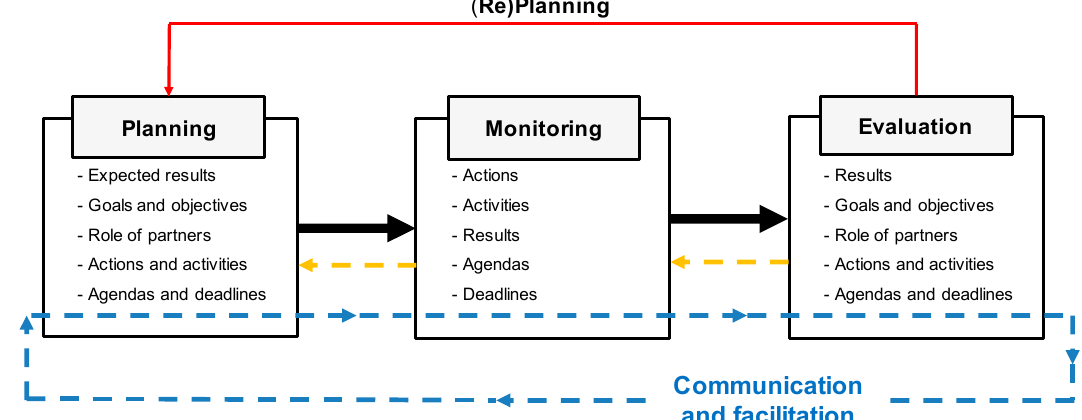
Figure 6. Recommendations for creating and maintaining partnerships.